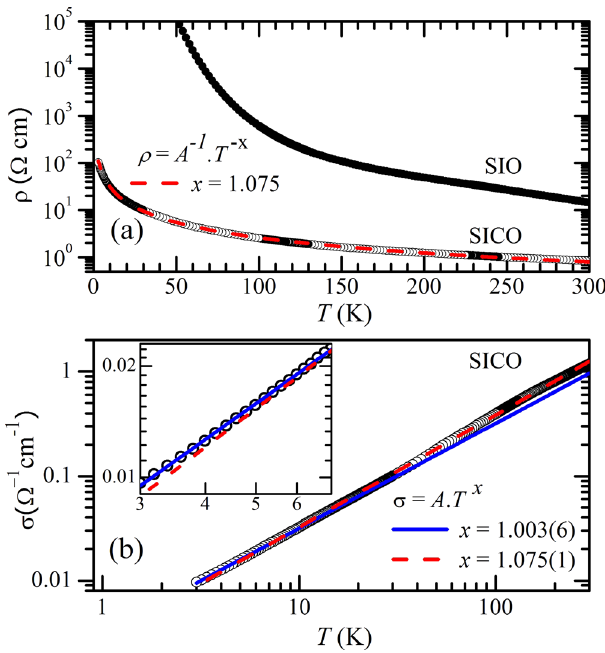
Fig. 3 Transport data at zero magnetic fi eld. a Temperature dependence of the electrical resistivity ρ ( T ) of Sr 2 IrO 4 (SIO) and Sr 2 Ir 0.95 Co 0.05 O 4 (SICO). The dashed line is the fi tted power-law behavior ρ ( T ) = A − 1 ⋅ T − x , where A and x = 1.075(1) are fi tting constants, revealing that SICO is at the onset of a metal-insulator quantum phase transition. b Electrical conductivity σ ( T ) in a double-log scale. The inset is a zoom out at low temperatures. The dashed and solid lines correspond to fi ts to σ ( T ) = A ⋅ T x with x = 1.075(1) and x = 1.003(6), respectively, where the latter exponent was obtained from fi tting low-temperature data only ( T < 6 K). Errors in parentheses are statistical only and represent one standard deviation obtained from the corresponding fi